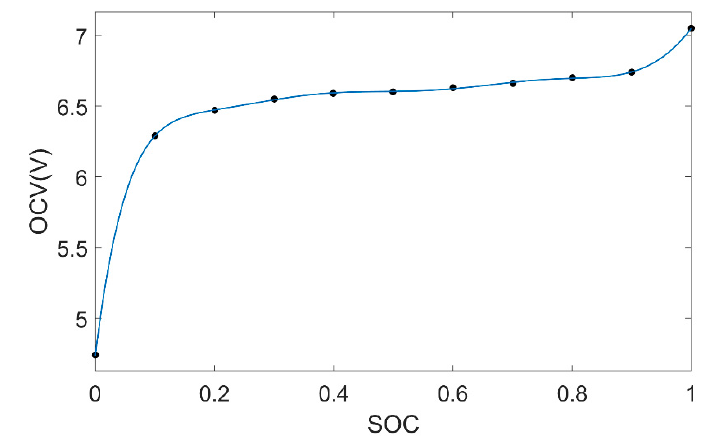
Figure 8. SOC–OCV fitting curve.